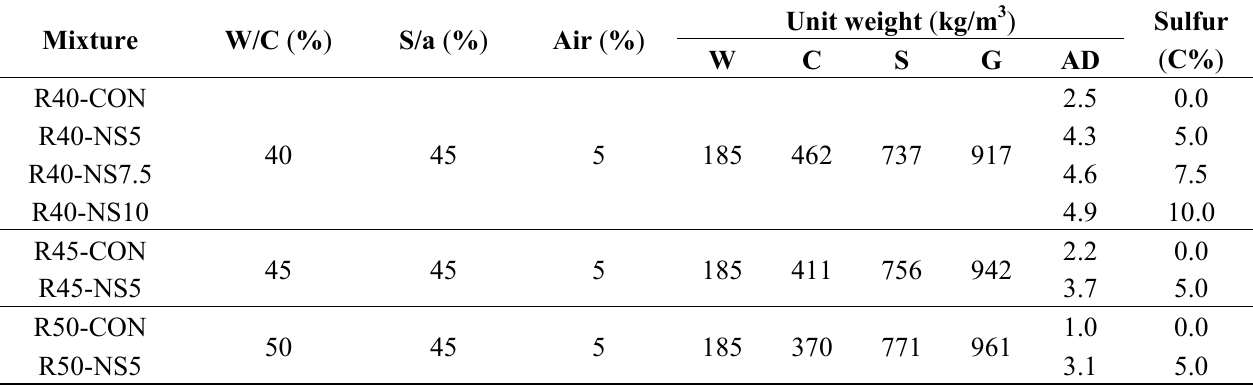
Table 6. Mix proportions of concrete